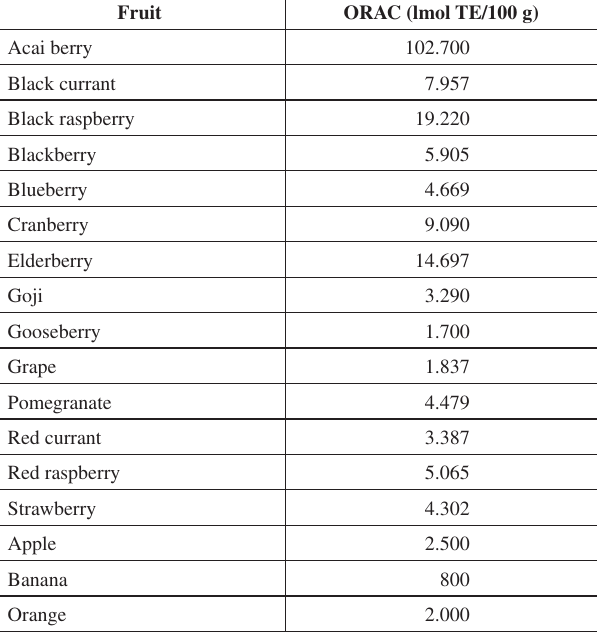
Table 3. Oxygen radical absorbance capacity (ORAC) of berries and other fruits (adapted from USDA